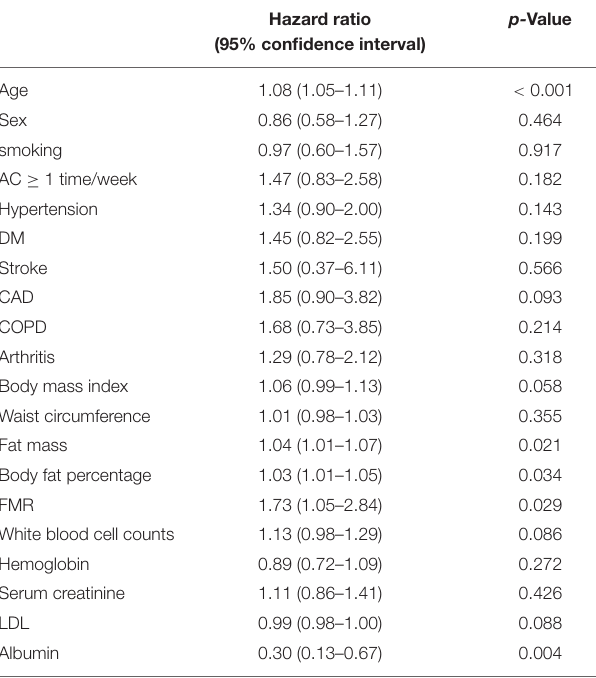
TABLE 2 | Hazard of covariates in participants transition from robust to dynapenia.